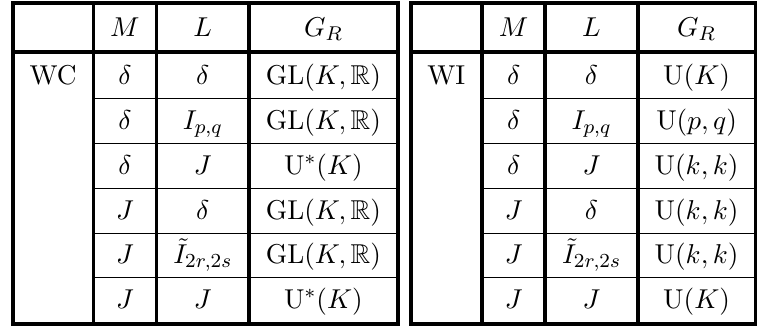
Table 6. In isotropic dimensions the R-symmetry groups are real forms of GL( K, C ) . Depending on whether the signature is Weyl-compatible (WC) or Weyl incompatible (WI), this table lists the R-symmetry groups for all possible combinations of a bilinear form M with a reality condition L